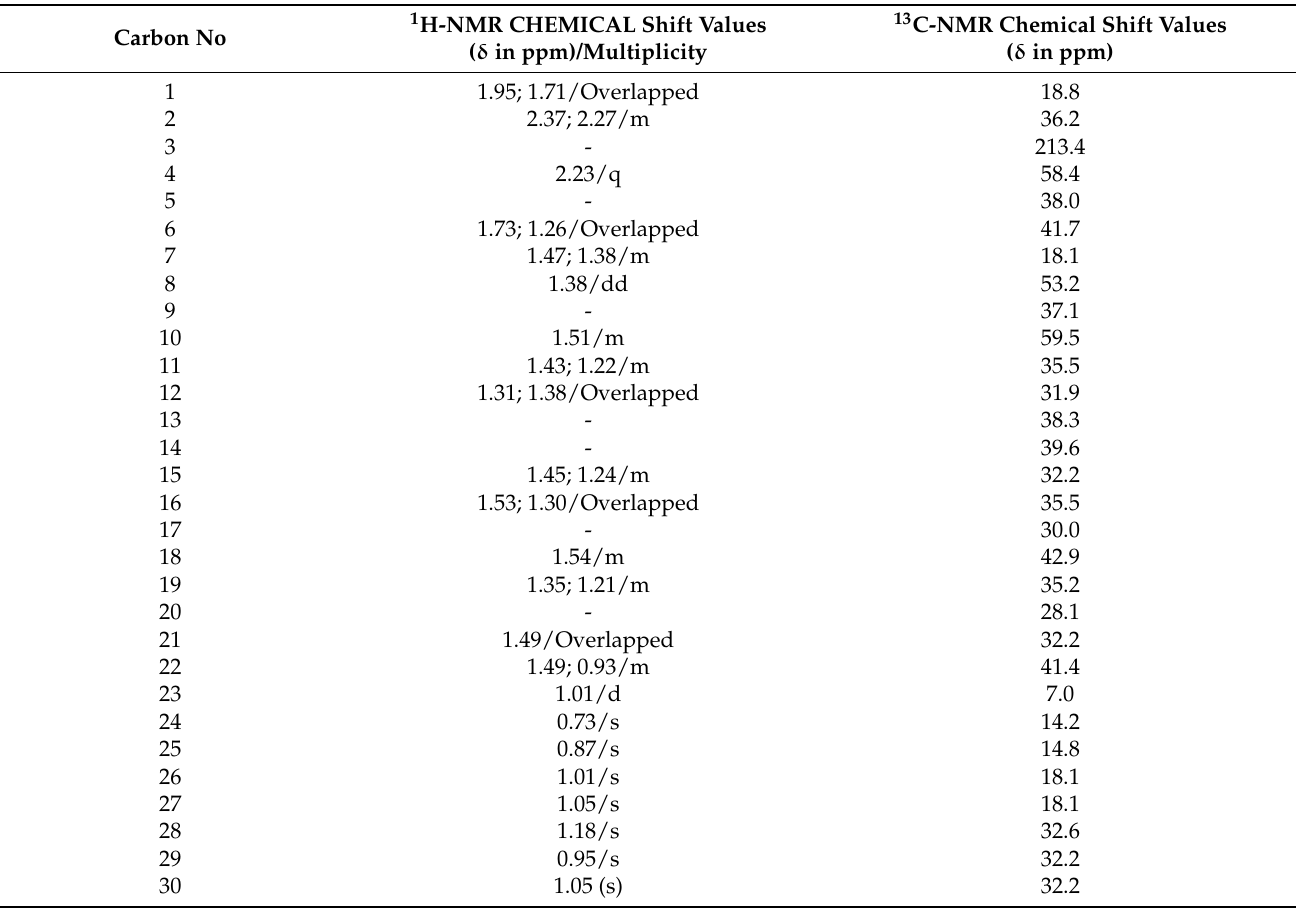
Figure 1. Chemical structure of friedelin 1 isolated from Syzygium cumin bark. Table 1. 1 H-NMR and 13 C-NMR data of friedelin.